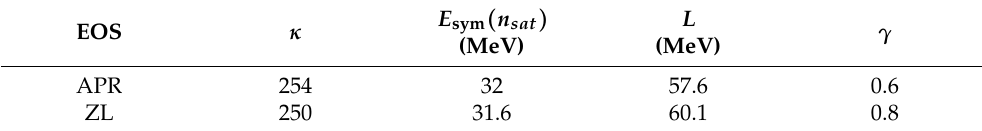
Table 1. Parameters of the cold EOS employed in this work.